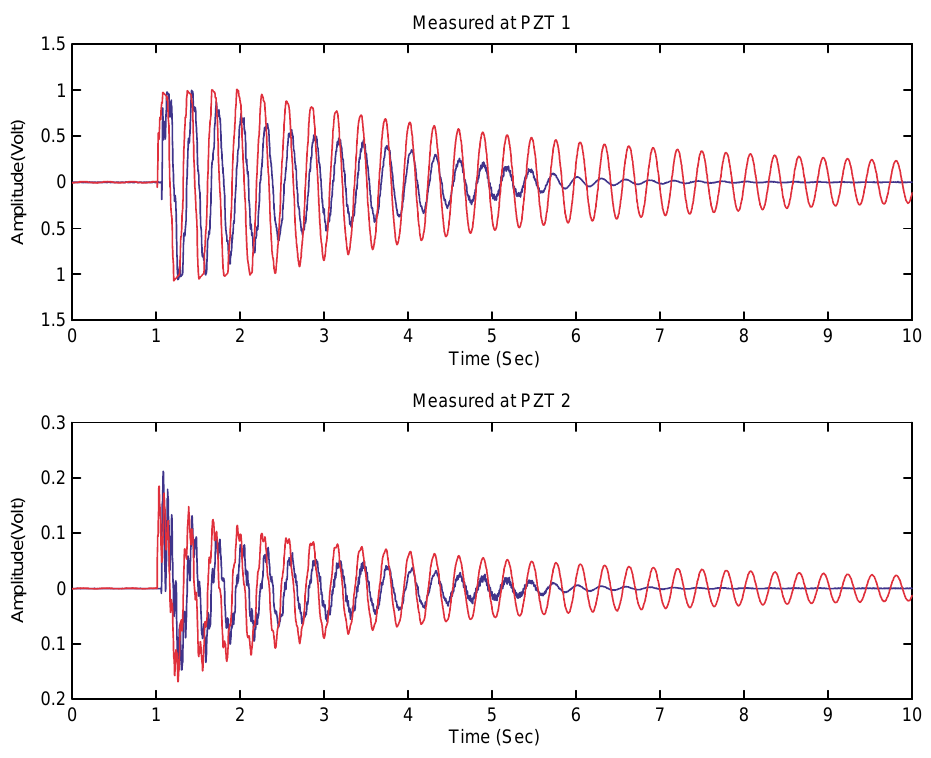
Fig. 9. The control performance of the sliding mode controller/ sliding mode